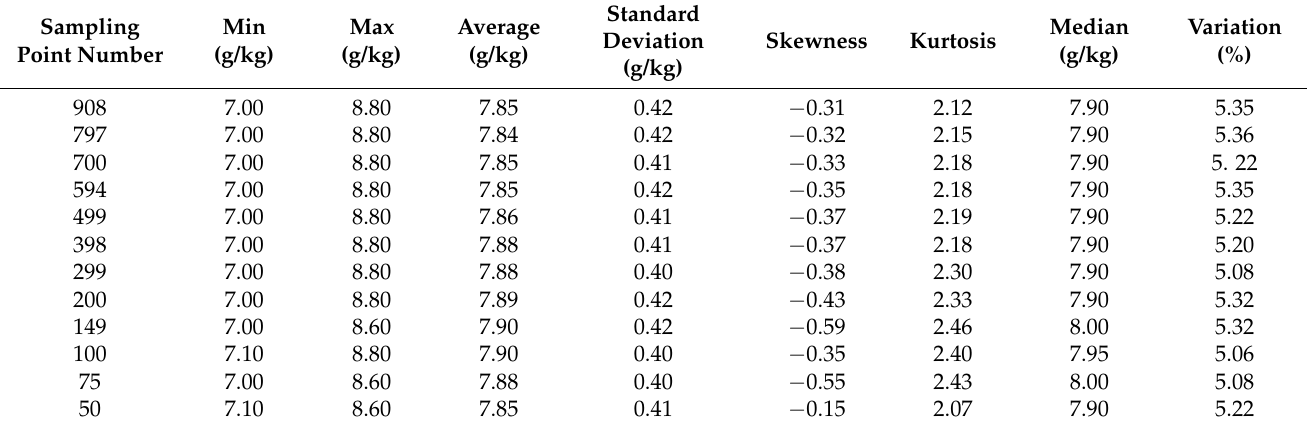
Table 1. Descriptive statistics characteristics of soil pH for different sets of sample